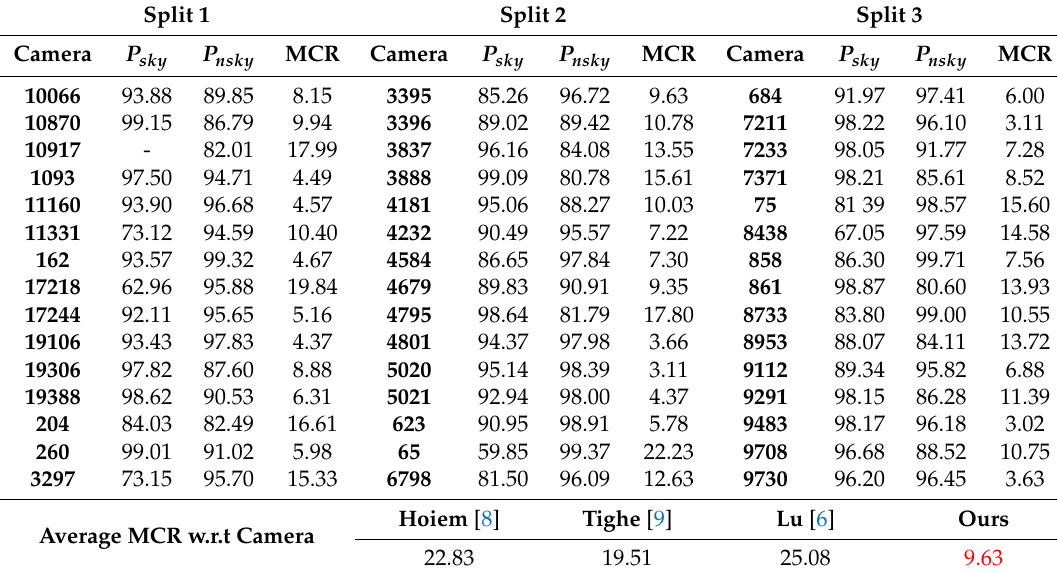
Table 3. Test results of 20% sample images for each camera in the SkyFinder dataset (%). We